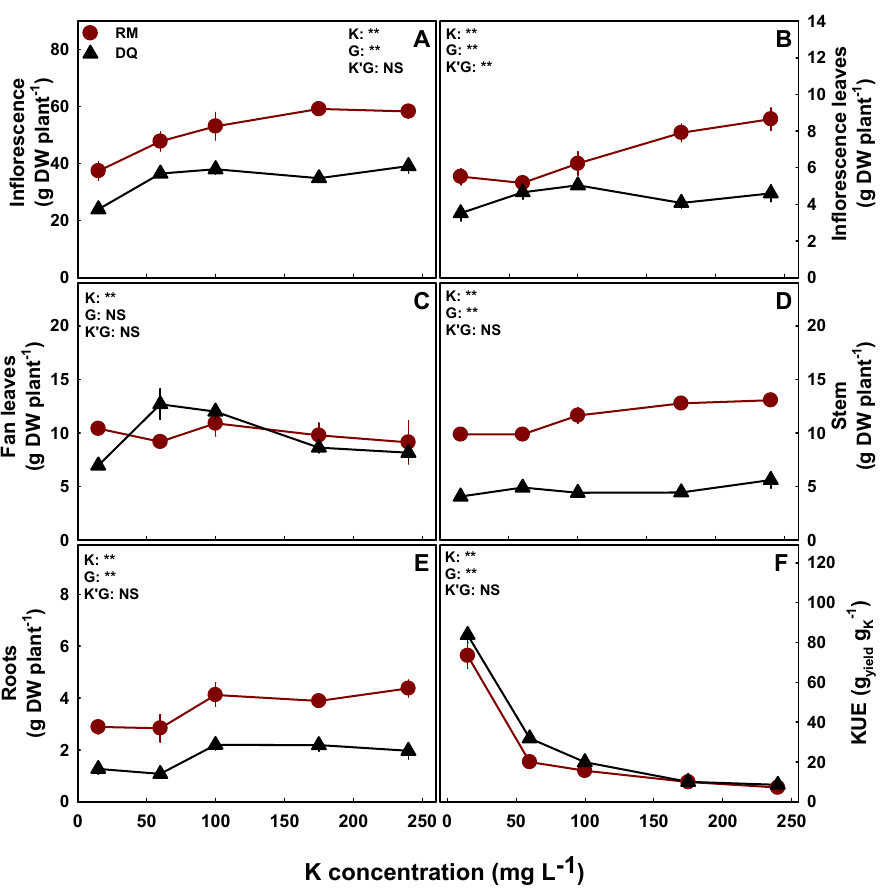
Figure 2. Effect of K supply on plant biomass in the medical cannabis cultivars RM and DQ. Dry weights of the inflorescences ( A ), inflorescence leaves ( B ), fan leaves ( C ), stem ( D ), and roots ( E ); and K use efficiency (KUE) ( F ). Presented data are averages ± SE ( n = 5). Where not seen, the error bars are smaller than the symbol size. Results of the 2-way ANOVA are indicated as ** p < 0.05, F -test; NS, not significant, p > 0.052. In the ANOVA results, K ’ G represents the interaction between K and the genotype.